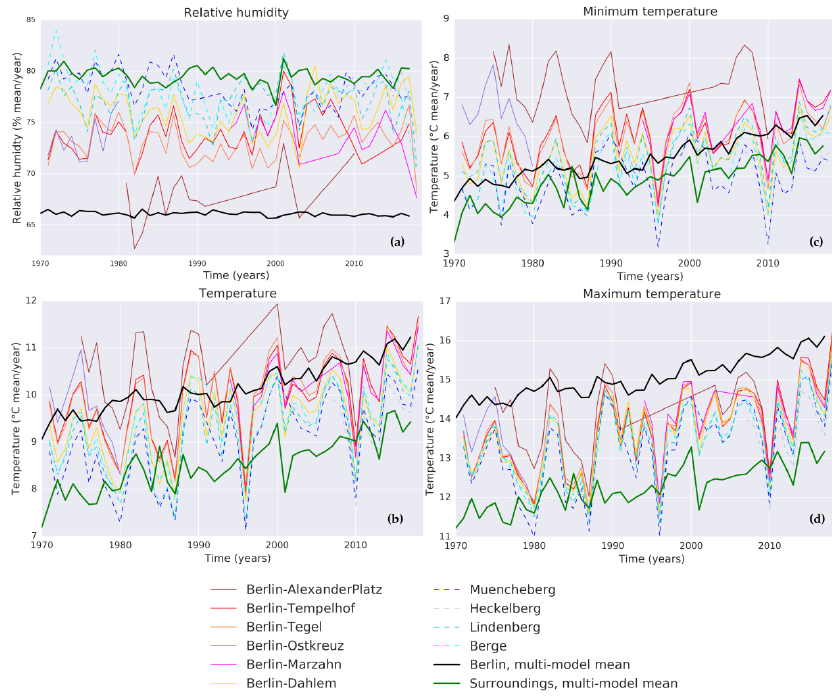
Figure 3. EURO-CORDEX multi-model annual mean compared to observation station data annual mean in Berlin and its surroundings for ( a ) relative humidity, ( b ) temperature, ( c ) minimum temperature, and ( d ) maximum temperature for 1970 – 2017. Atmosphere 2019 , 10 , x FOR PEER REVIEW